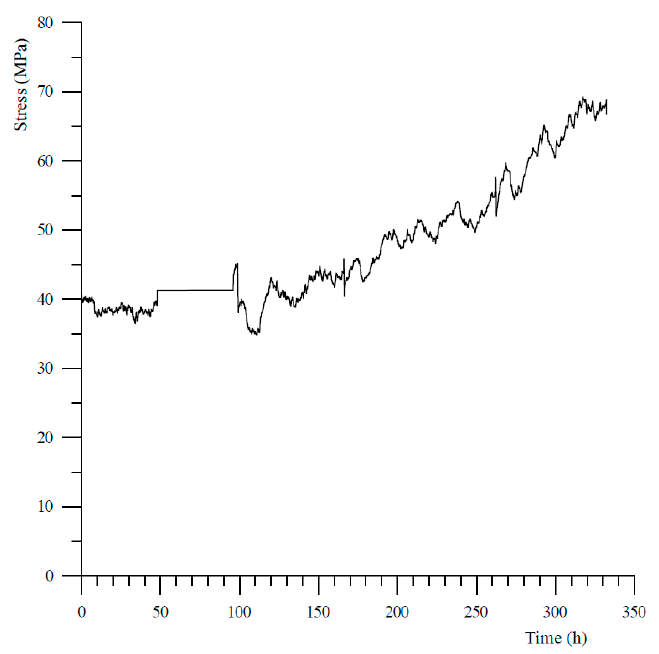
Figure 3. The change in stress on sample R0803 vs. time, after correction for changes in CO 2 -pressure.